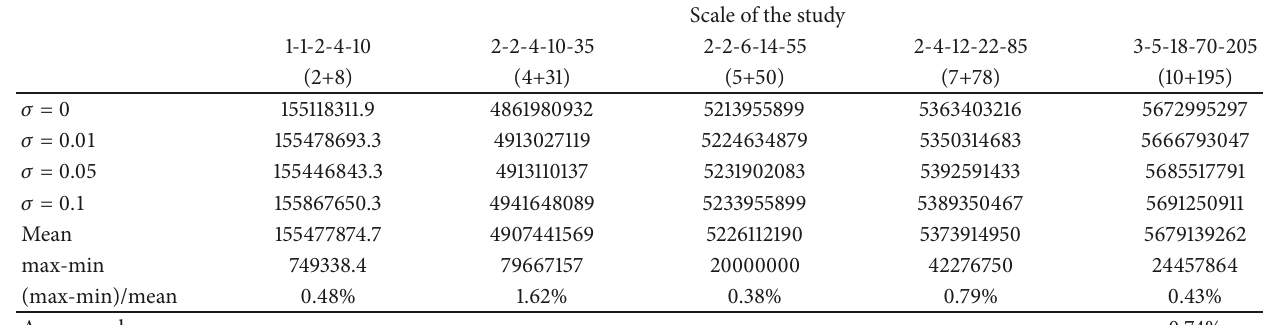
Table 5: Comparison of costs and product volume when demand changes.